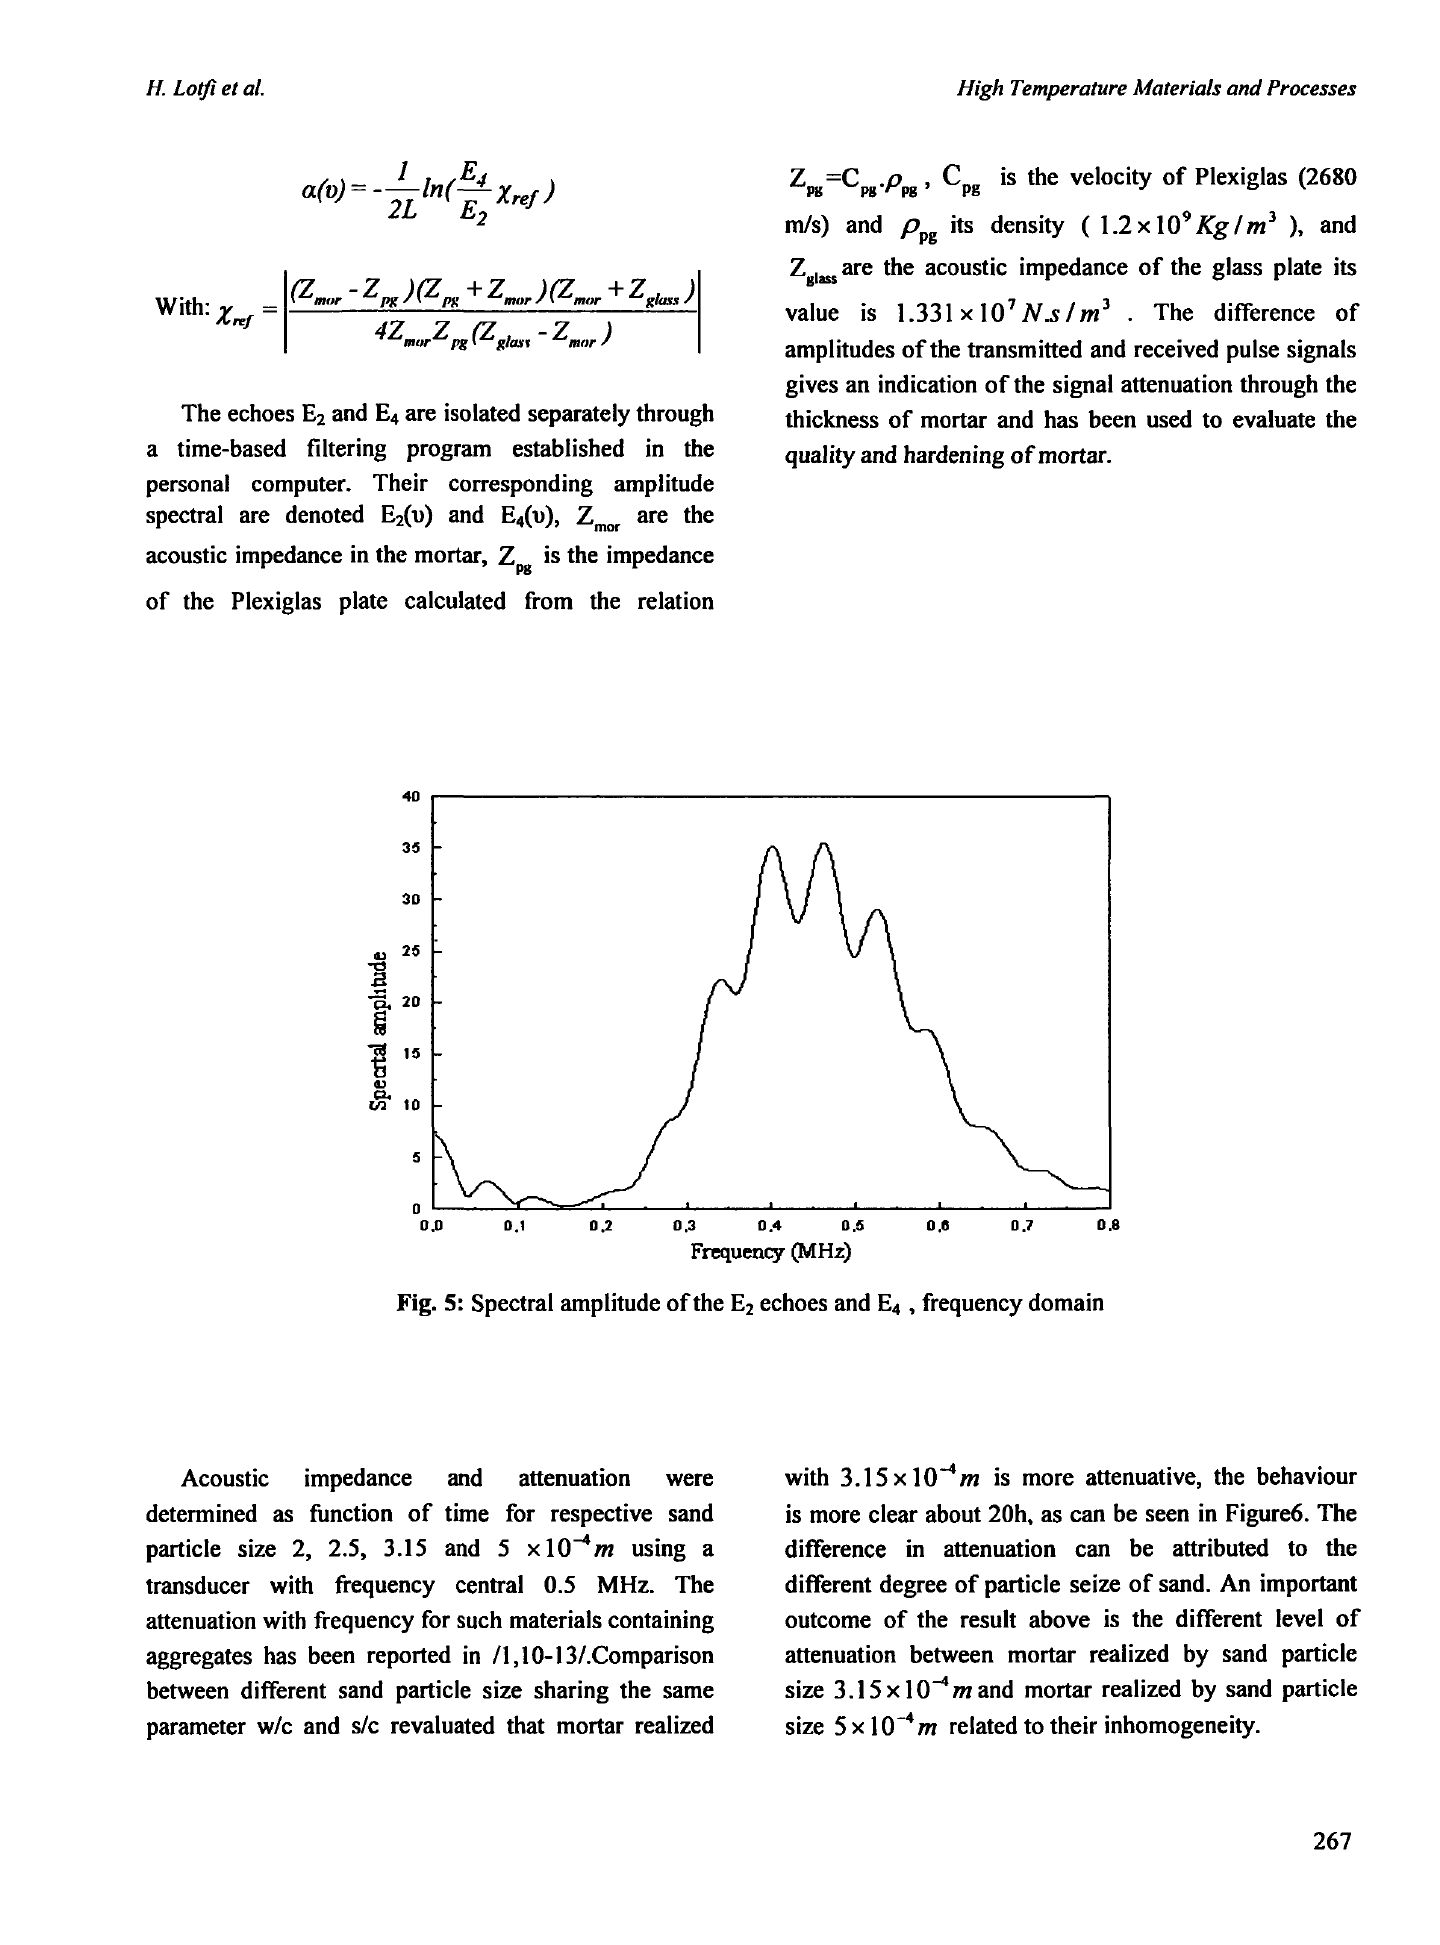
Fig. 5: Spectral amplitude of the E